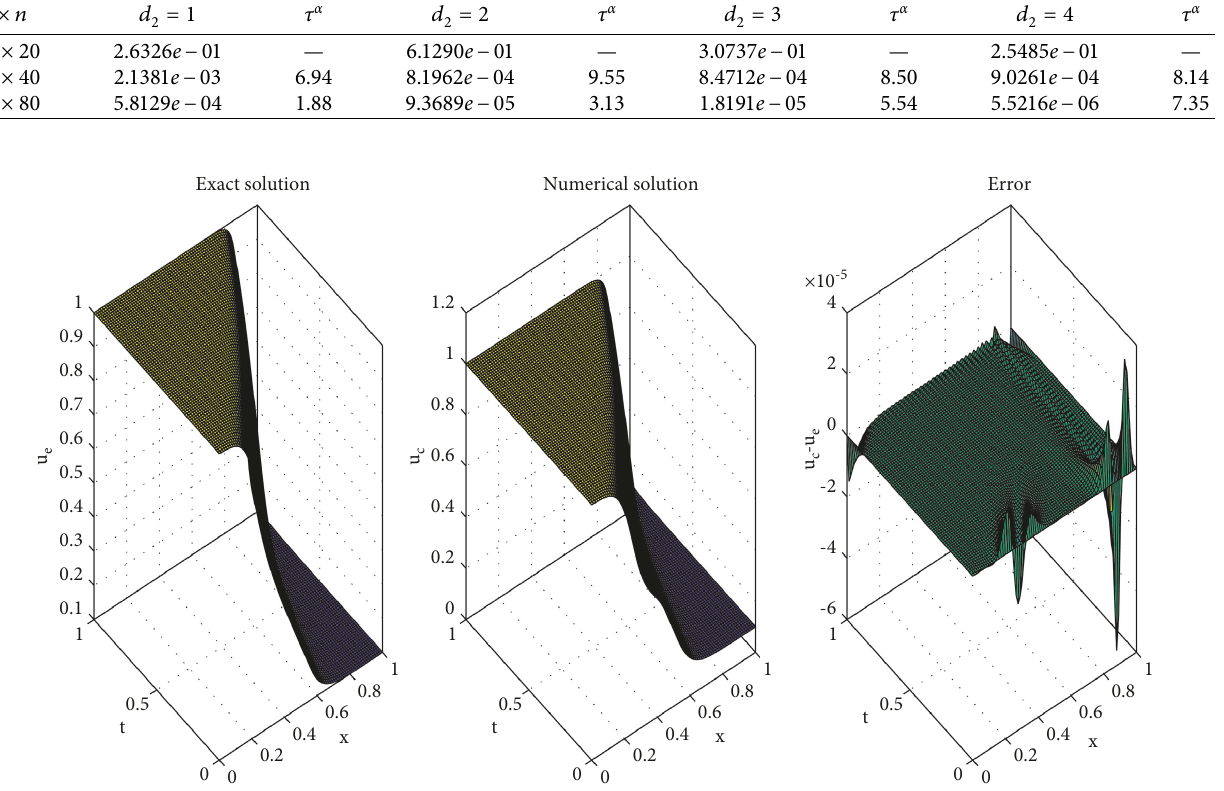
Table 8: Errors and convergence rates in the case of equidistant nodes with space interpolation parameter d m × n